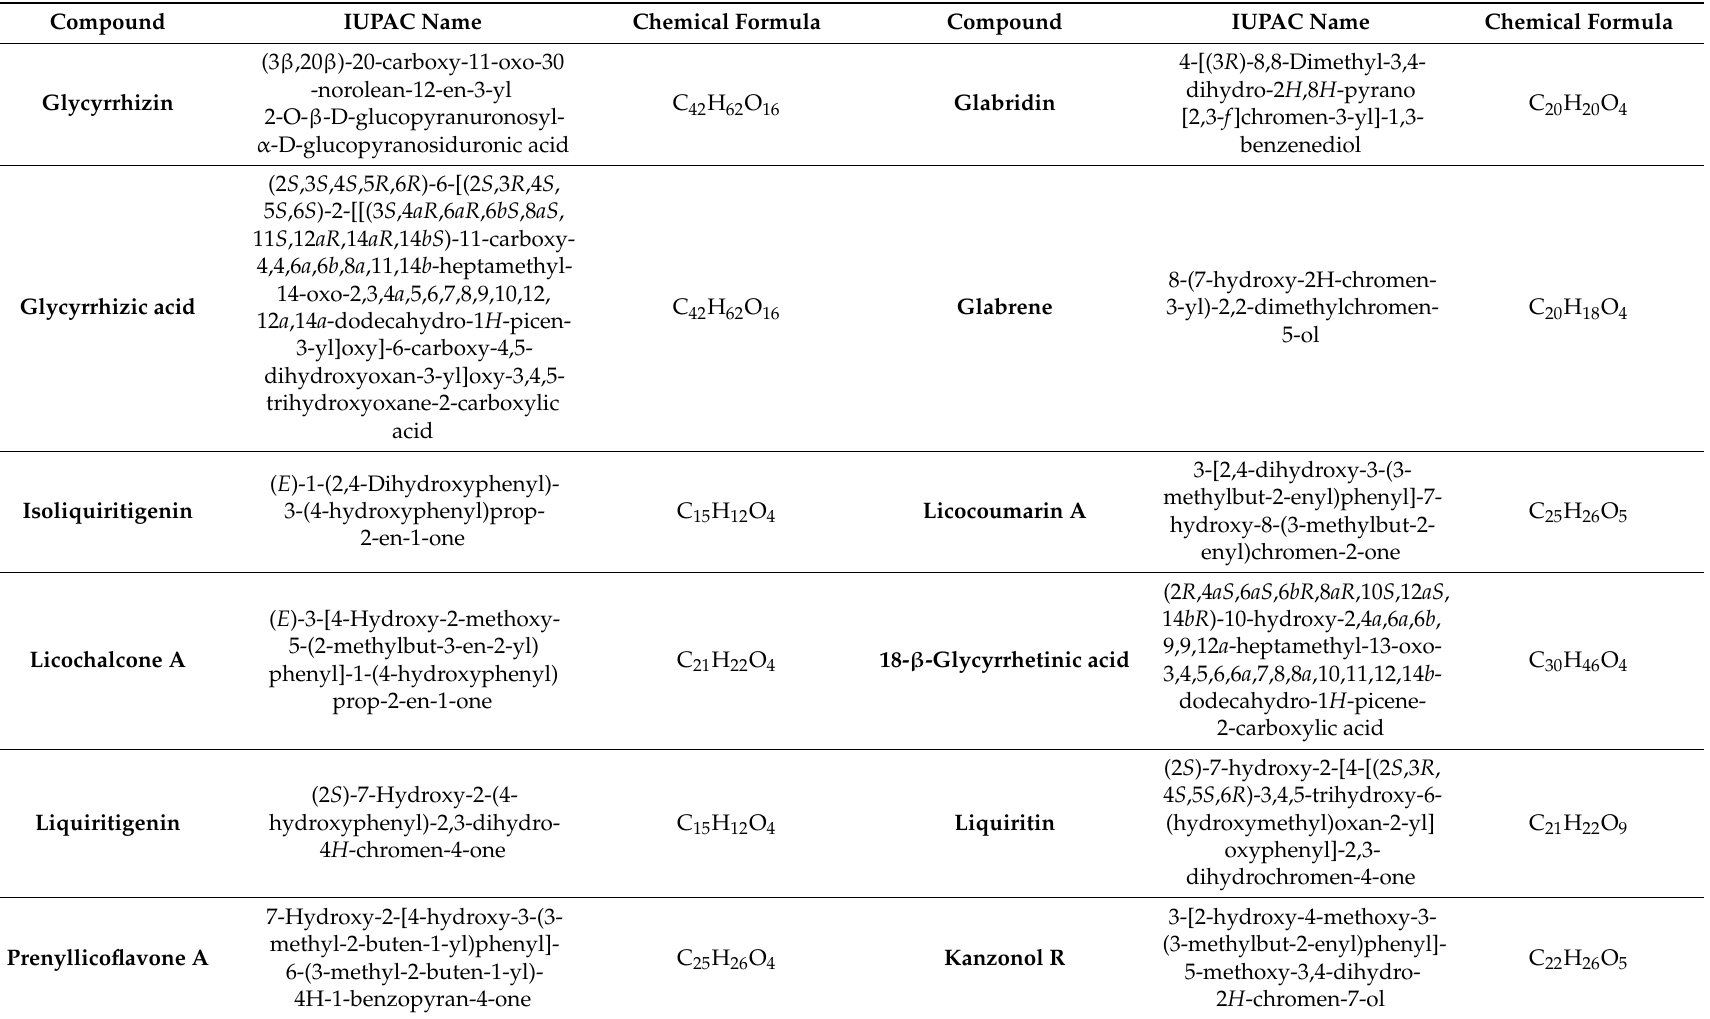
Table 2. International Union of Pure and Applied Chemistry (IUPAC) name and chemical formula of bioactive molecules isolated from G.